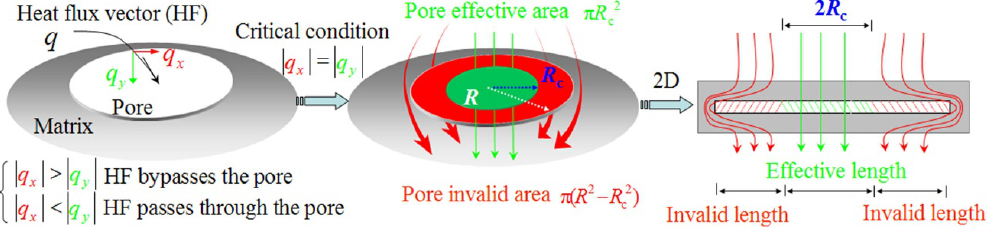
Fig. 62 Schematics describing the effective and invalid parts of the pore. Reproduced with permission from Ref. [365], © ASM International